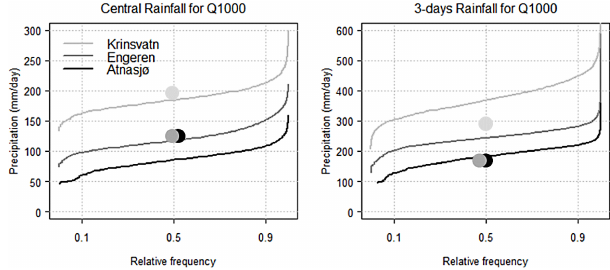
Figure 12. Distributions of central (i.e. 1-day) and 3-day rain- fall volumes associated with the 10 4 simulated events producing a 1000-year discharge (Q1000). The values for the design precipi- tation sequence used in PQRUT are also indicated with solid dots.